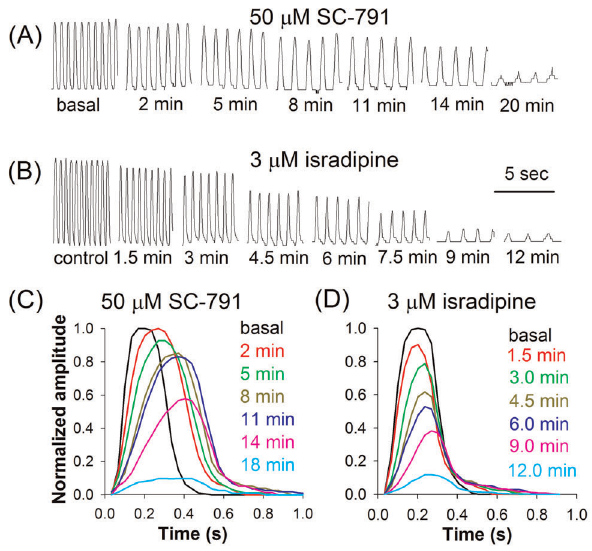
Figure 4. Heartbeat disruption by SC-791 and isradipine. Development of heartbeat stoppage in the presence of 50 m M SC-791 ( A ) or 3 m M isradipine ( B ). The corresponding averaged contraction waveforms demonstrate similarities (decrease in amplitude) and differences (prolongation of contraction) between the effects of SC- 791 ( C ) and isradipine ( D ); each waveform is an average of 10 to 20 individual contraction waveforms.